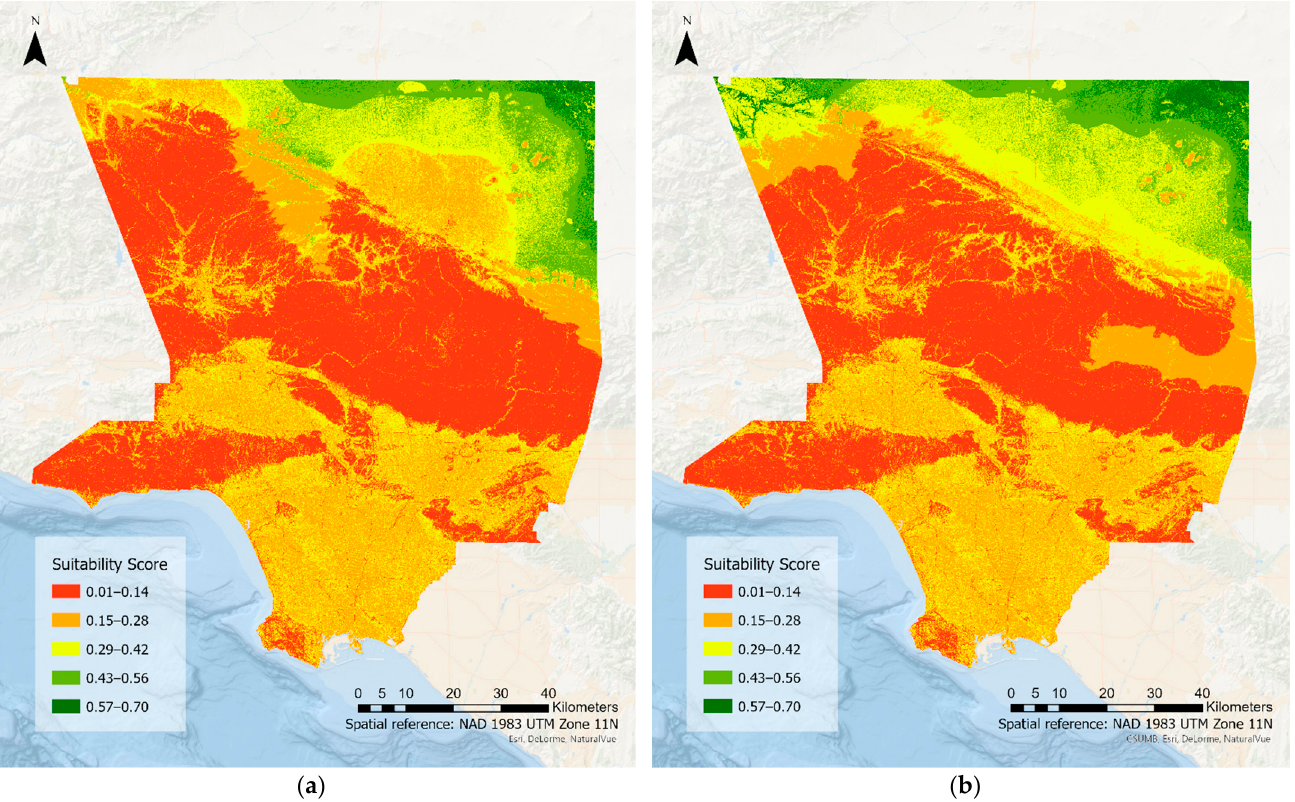
Figure 3. Earthquake shelter suitability raster for Los Angeles County ( a ) in no tsunami scenario and ( b ) tsunami scenario.